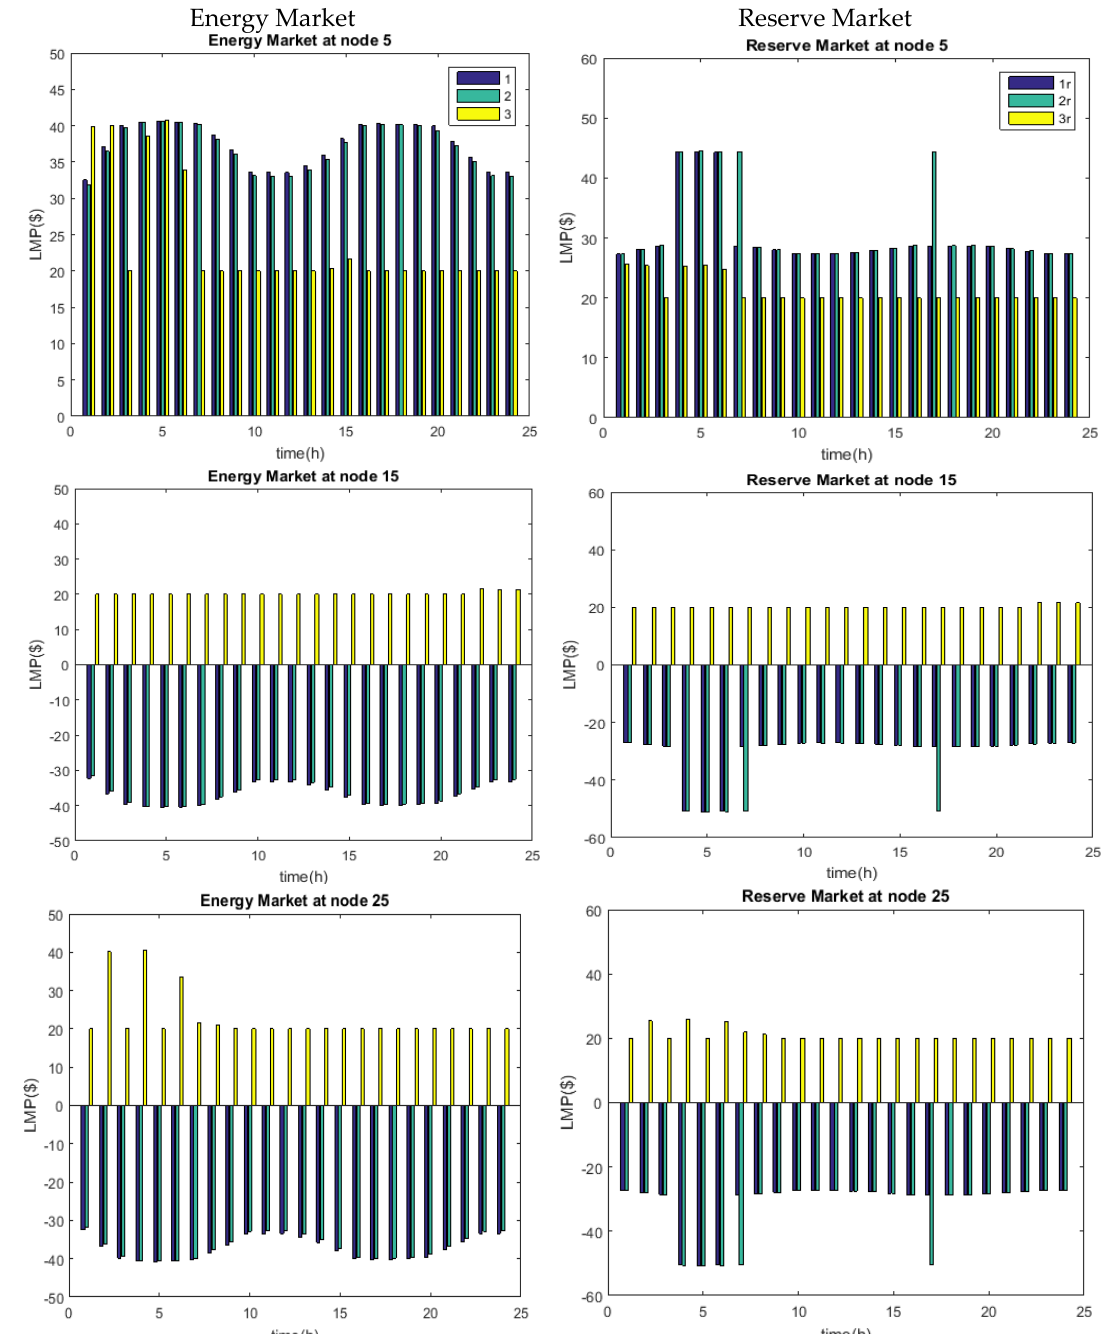
Figure 4. The marginal prices for the energy and reserve markets.